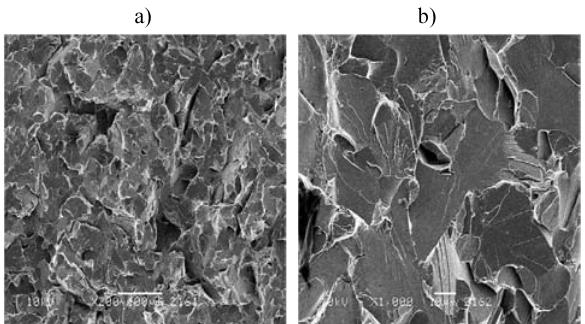
Fig. 8. Fracture morphology of impact resistance samples from tank No. 4 broken at –20 ° C. Brittle trans-crystalline fracture. Magnification: a) 200 times, b) 1000